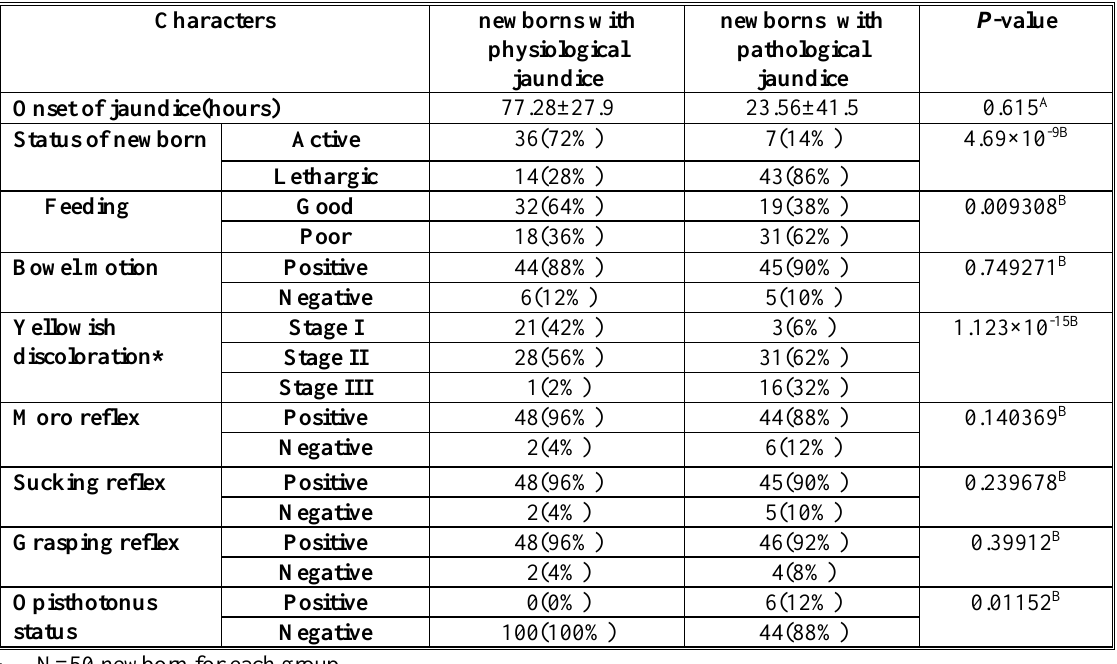
Table 3 represents the onset of jaundice and physical examination findings, there is a significant difference between the onset of Physiological jaundice and pathological jaundice (77.28±27.9 vs23.56±41.5) ( P-value <0.05). According to the general status, feeding status, the stage of yellowish discoloration and opisthotonus status of newborns there is a significant relationship when comparing Table 3.Clinical examinations of newborns with physiological and pathological jaundice